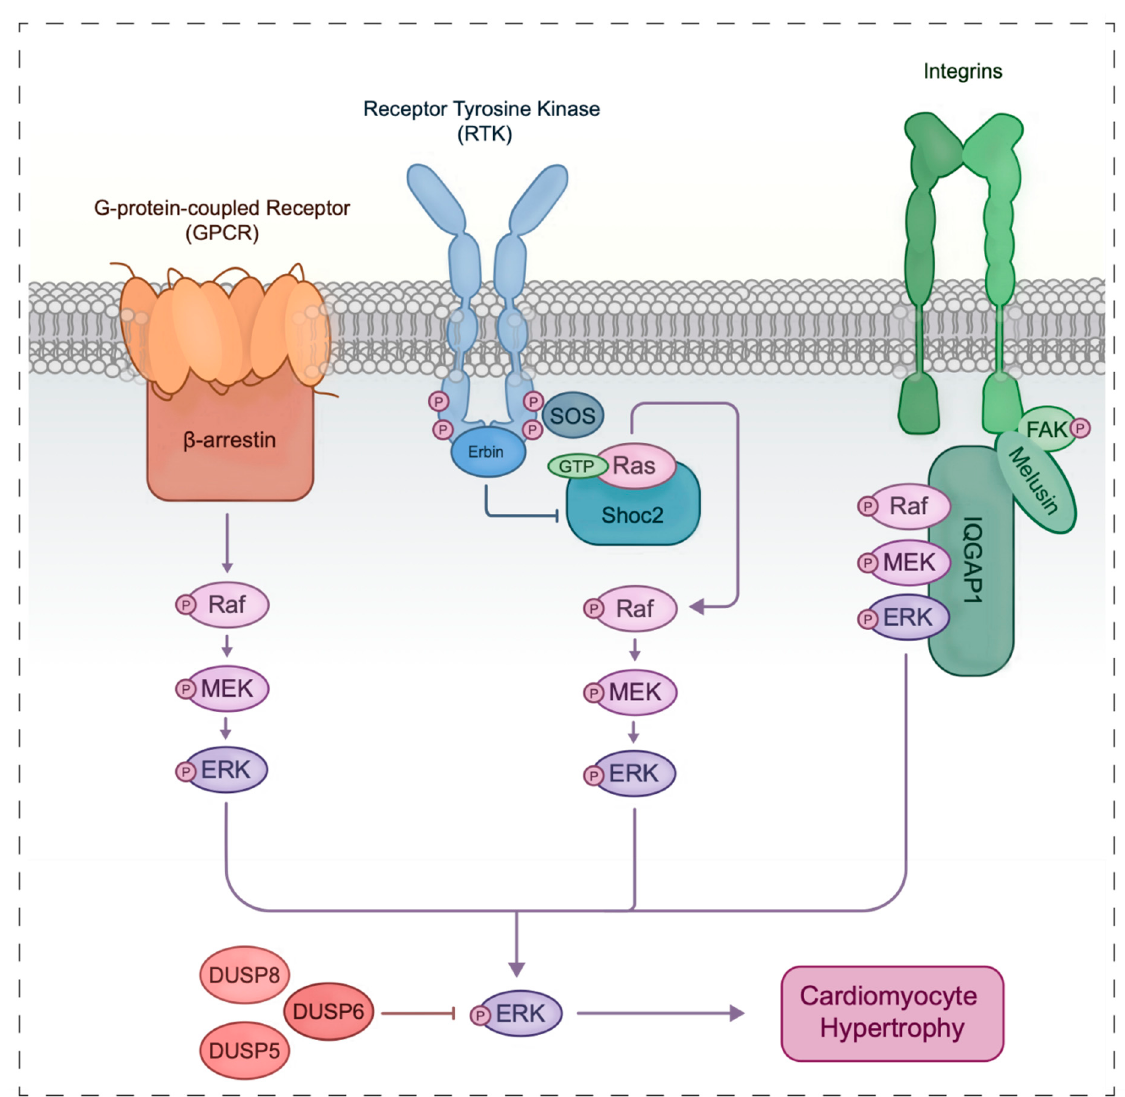
Figure 1. The cardiomyocyte ERK signaling event framework, where extracellular cues drive the activation of G-protein- coupled receptors (GPCRs), receptor tyrosine kinases (RTKs), and integrins to elicit ERK signaling and cardiomyocyte hypertrophy. For RTKs, the SOS exchange the SOS exchange factor activates Ras, scaffolded by Shoc2, to promote serial phosphorylation and downstream ERK activation. GPCR and integrin activation can occur under cardiomyocyte stress with respective scaffolding complexes ( β -arrestin for GPCRs and the IQGAP1-Melusin-FAK supercomplex for integrins) functioning to temporally and spatially modulate the transduced signal. Active ERK functions to drive cardiomyocyte hypertrophy through the phosphorylation of cytoplasmic, cytoskeletal, and nuclear targets to modulate gene expression. Specific phosphatases such as DUSP5, 6 and 8 act to temporally limit ERK activation and favor signal termination.